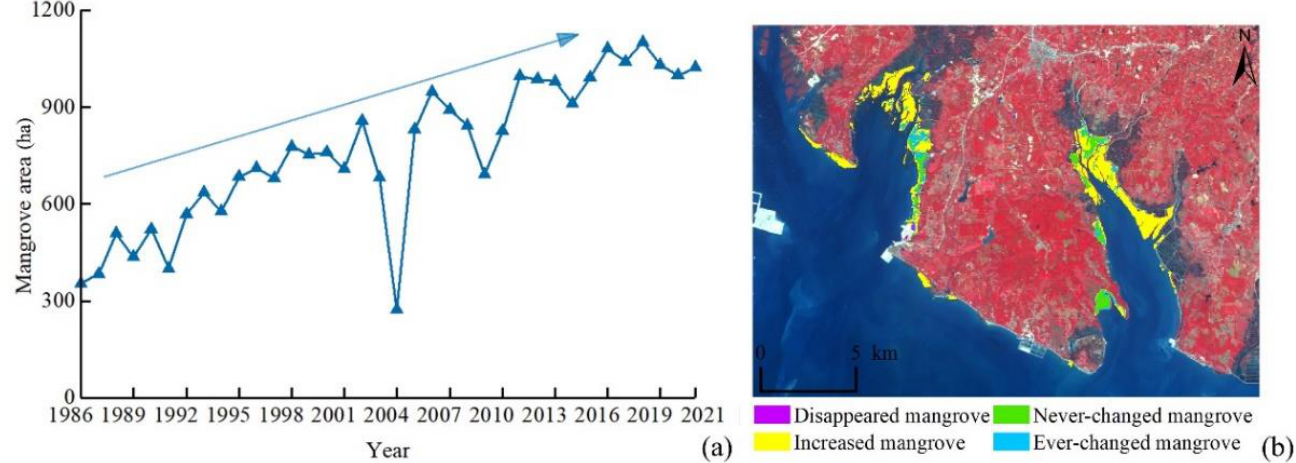
Figure 11. ( a ) Mangrove area of SMNR and ( b ) changes to mangroves in SMNR and part of ZMNR during 1986 – 2021.